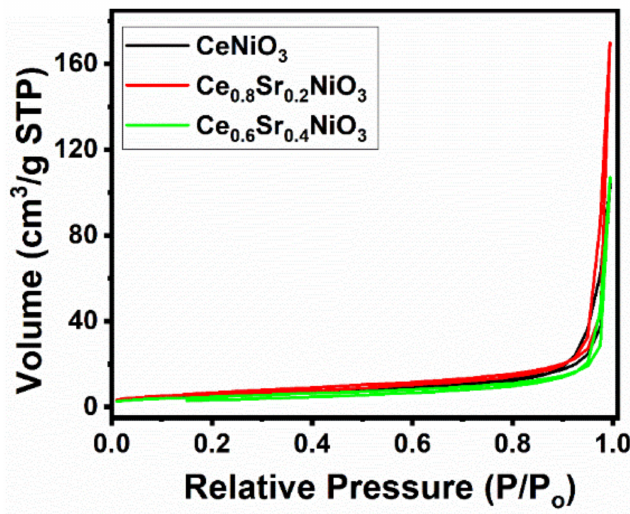
Figure 3. N 2 adsorption–desorption isotherms of Ce x Sr 1 − x NiO 3 (x = 0.6–1) perovskites. Table 1. Textural properties and deactivation factors of Ce x Sr 1 − x NiO 3 (x = 0.6–1) perovskites.